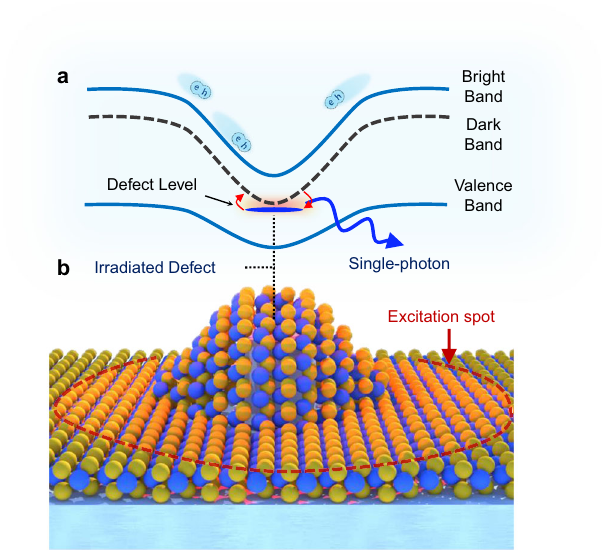
Fig. 1 Illustration of a strain and defect-engineered WSe 2 single-photon emitter. a Denotes the spatial bandgap variations due to strain (solid blue lines represent excitonic bright band and valence band, respectively, dashed gray line represents the dark excitonic band). b Demonstrates an illustration of 1L-WSe 2 strained over a SiO 2 nanopillar (W atoms in blue and Se in yellow). Neutral excitons, represented as e – h pairs, created within the excitation laser spot (red dashed line) funnel to low-potential strained regions. Note that WSe 2 also has a dark-exciton band at energies below the bright exciton, which is optically forbidden due to the transition selection of WSe 2 . However, at strained regions and in the presence of a defect (top of the irradiated nanopillar, denoted with a blue dash), the dark-exciton can become strain-tuned to a defect-level forming intervalley defect excitons. Given that the defect-level breaks the spin-momentum locking of WSe 2 , the dark-exciton state can then ef fi ciently recombine through the defect level, giving rise to an exponentially bright single-photon emission line (outgoing blue